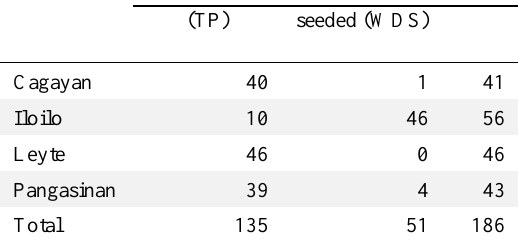
Table 2. Distribution of rice fields surveyed during the wet season 2018 by province and crop establishment method.